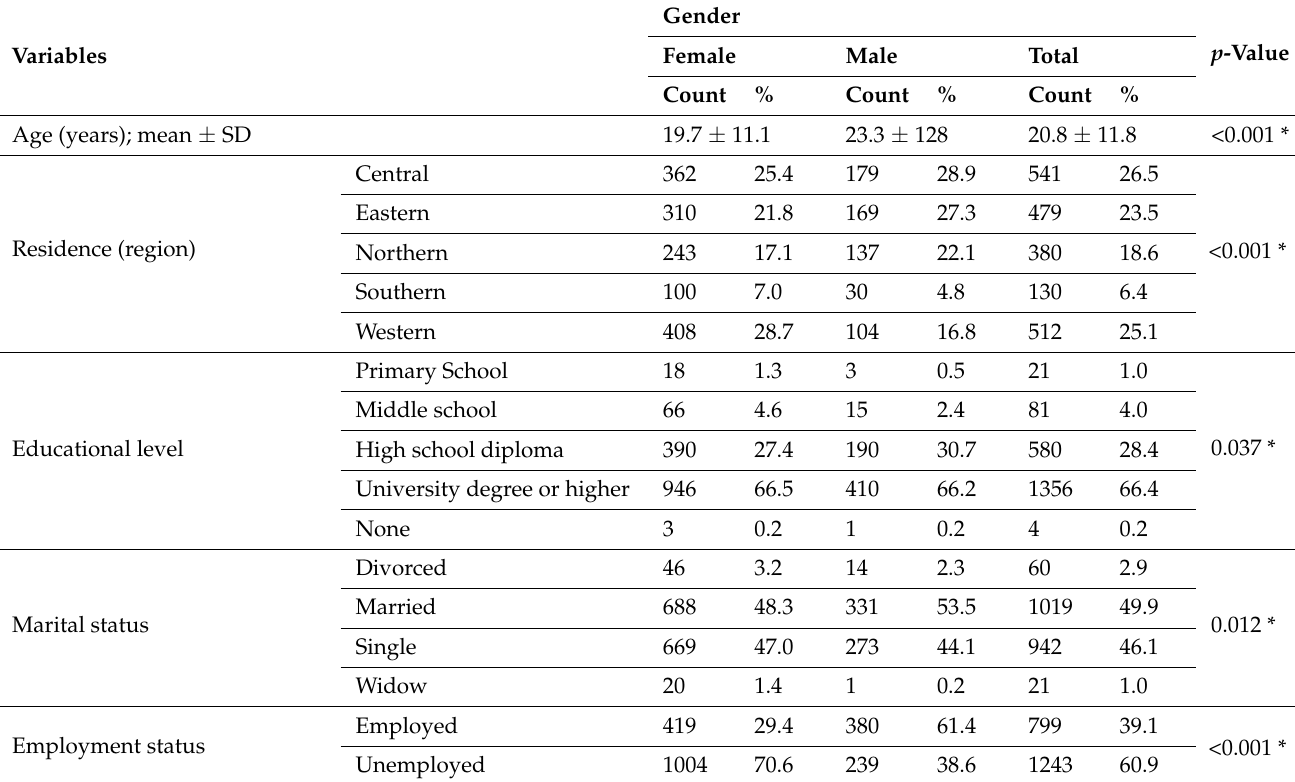
Table 1. Sociodemographic characteristics of the